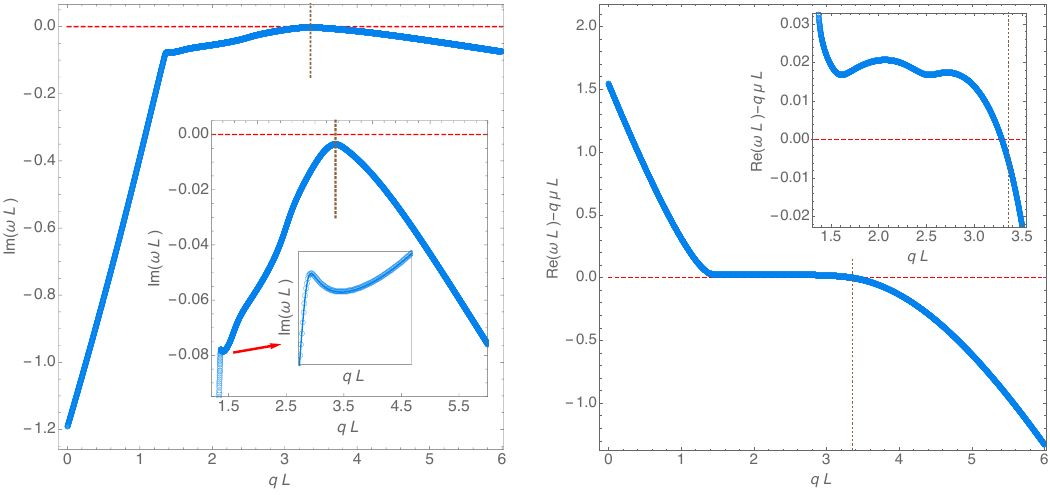
Figure 9 . Dirac (cid:12)eld frequency with standard quantization (2.43) as a function of the dimensionless scalar charge qL for a AdS-RN black hole with (cid:22) = 0 : 99 (cid:22) ext and r + =L = 0 : 5 (also, mL = 0 and ‘ = 1 = 2). Left panel : Imaginary part of the dimensionless frequency, Im( !L ) which attains a maximum of Im( !L ) (cid:24) (cid:0) 0 : 0037491 for q = q max (cid:24) 3 : 3555 =L (vertical brown dashed line). The main inset plot zooms-in around this maximum and shows that Im( !L ) < 0 for any qL . The secondary inset plot shows the detail of the curve around qL (cid:24) 1 : 45 to show that the apparent cusp in the main plot is smooth. Right panel : Real part of the dimensionless frequency, Re( !L ), measured with respect to q(cid:22)L . This quantity changes sign at q = q ? (cid:24) 3 : 2873 =L with q ? < q max , i.e. for a smaller qL than the one where Im( !L ) attains its maximum value (vertical brown dashed line): this is better seen in the inset plot which zooms-in the relevant